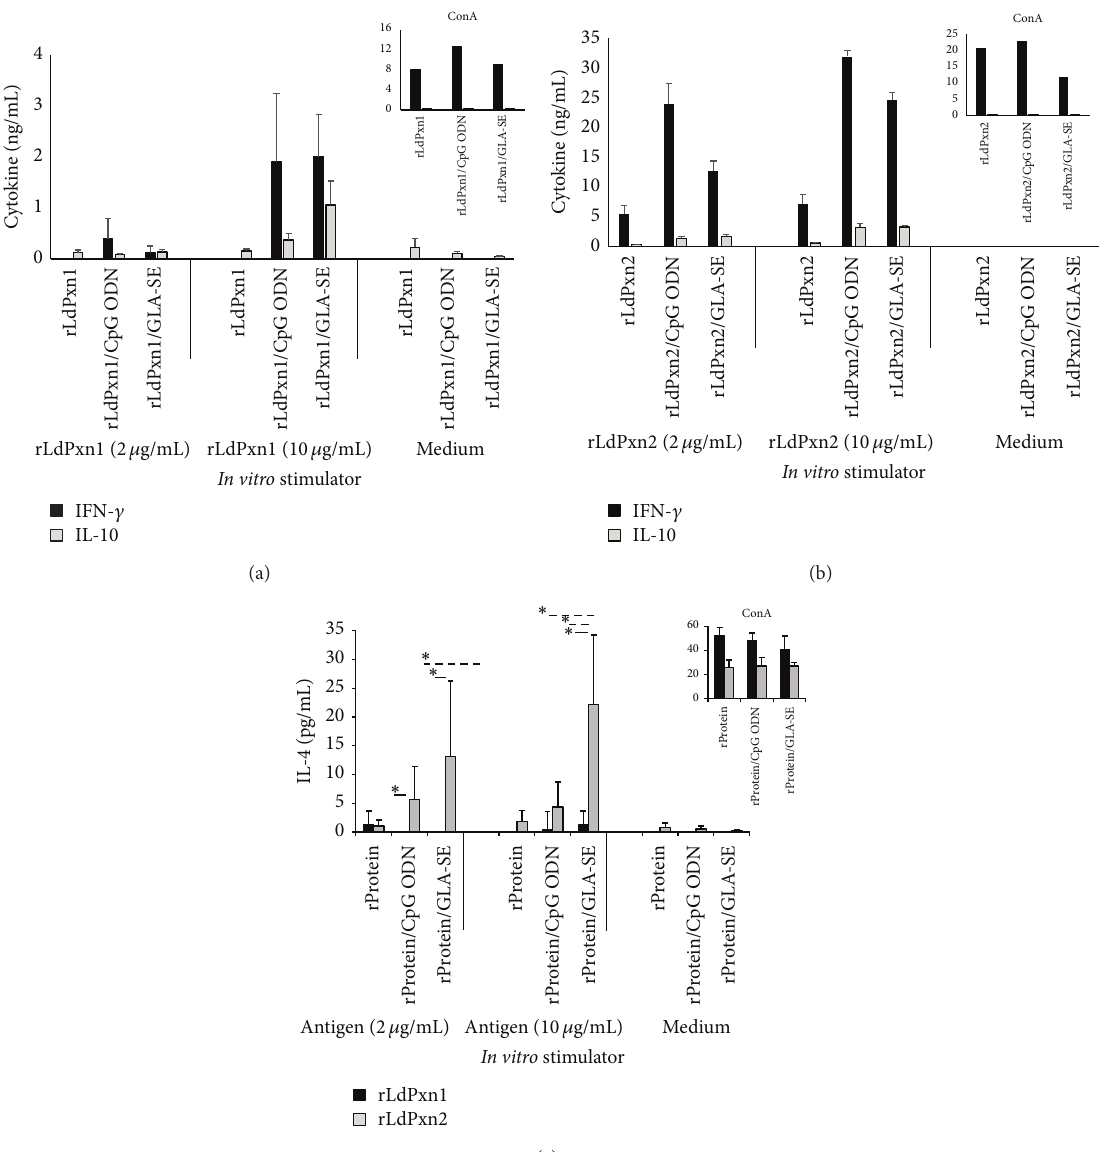
Figure 5: Cytokine responses in spleen cells of rLdPxn1 and rLdPxn2 immunized mice. Mice were immunized s.c. three times at three-week intervals with rLdPxn1 or rLdPxn2 with or without CpG ODN or GLA-SE. Four weeks after the last immunization, spleen cells were prepared and in vitro stimulated with the respective antigen (2 and 10 𝜇 g/mL) or ConA (5 𝜇 g/mL). The release of IFN- 𝛾 (ng/mL), IL-10 (ng/mL), and IL-4 (pg/mL) in immunized mice was measured in supernatants after 72 hr of in vitro stimulation at 37 ∘ C. Results are presented as the amount of IFN- 𝛾 (ng/mL) and IL-10 (ng/mL) for rLdPxn1 (a) and rLdPxn2 (b) or the amount of IL-4 (pg/mL) of rLdPxn1 and rLdPxn2